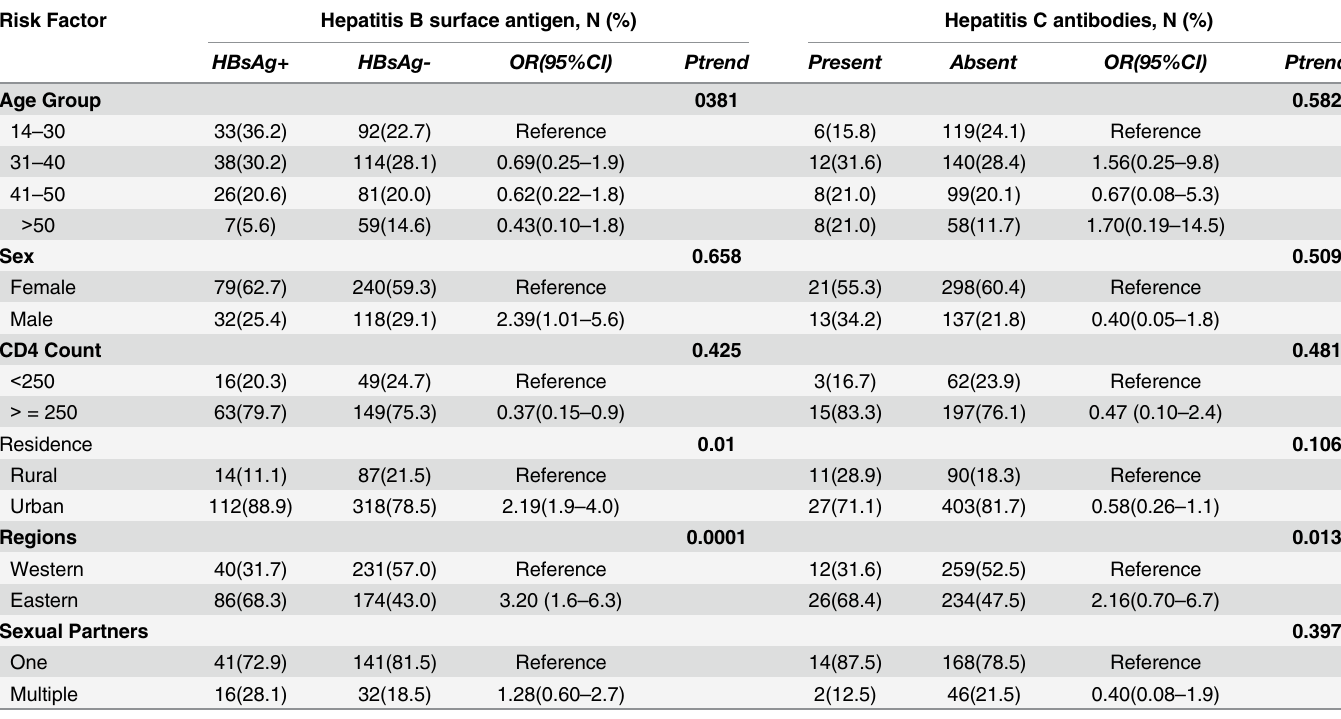
Table 3. Associations of demographic and serological markers with risk of infection with HBV or